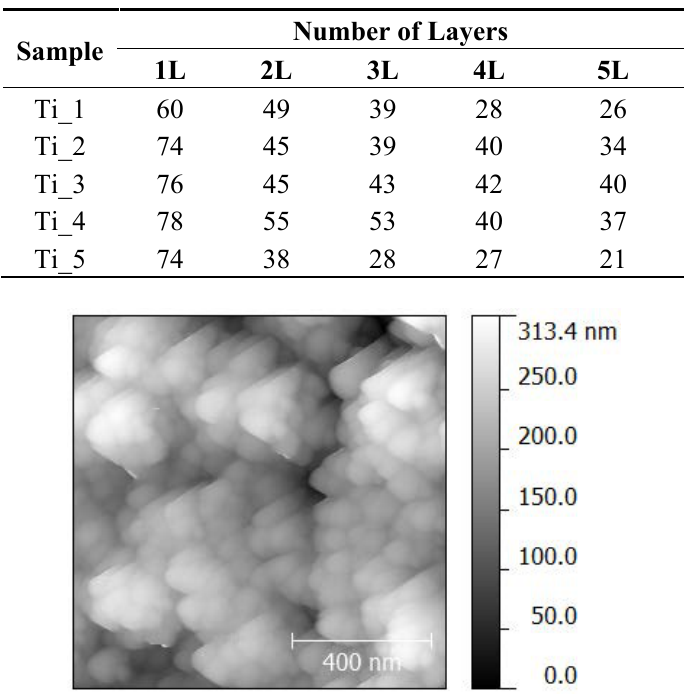
Table 3. RMS roughness (nm) of printed samples obtained from AFM.